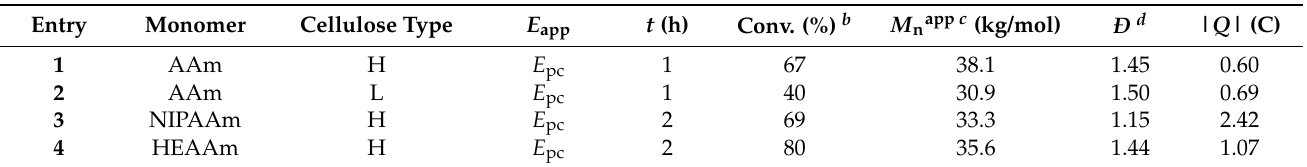
Table 3. Self-degassing potentiostatic se ATRP of Aam, HEAAm, and NIPAAm (all 10 wt%) starting from cellulose-BriB (H = high, L = low) in the presence of 0.05 M SP as ROS scavenger and 0.1 M NaBr as supporting electrolyte. Reaction volume is 15 mL. a .